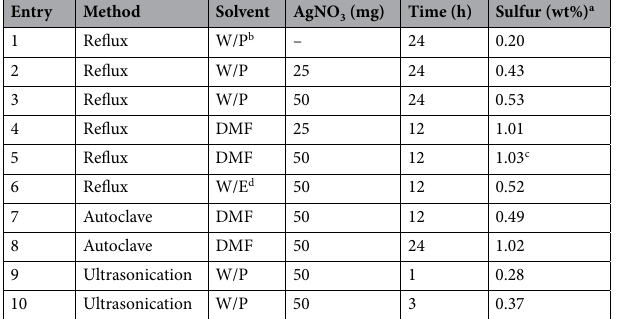
Table 1. The obtained results from the optimization of the Diels–Alder Reaction onto the surface of Fe 3 O 4 @ SiO